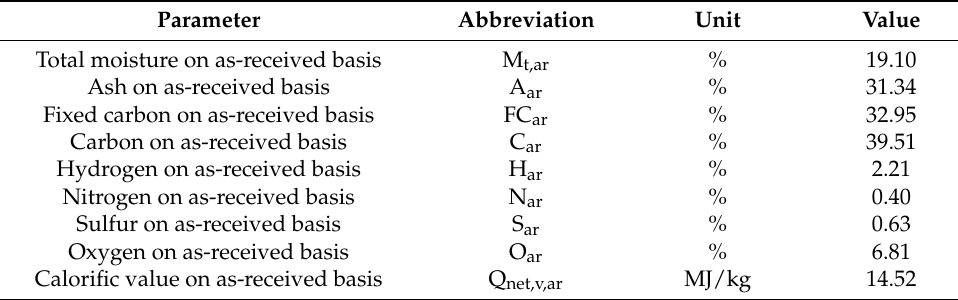
Table 2. Basic parameters of the design fuel.